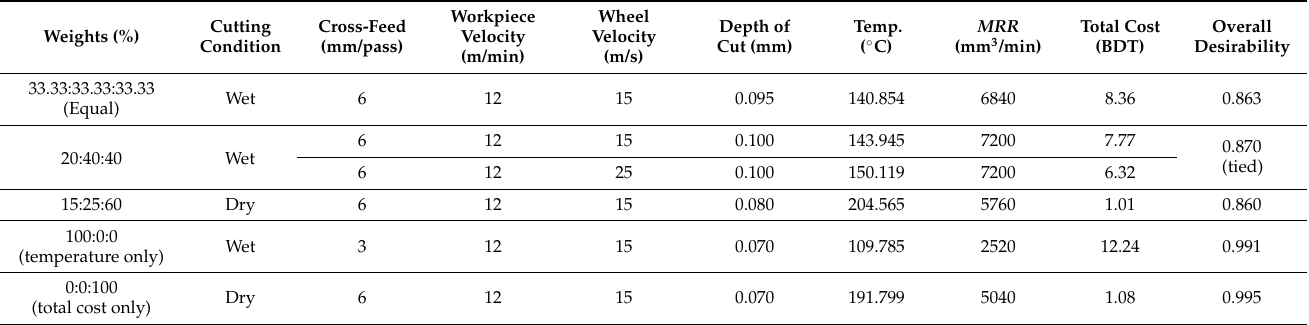
Table 8. Optimum cutting parameters and corresponding responses for different